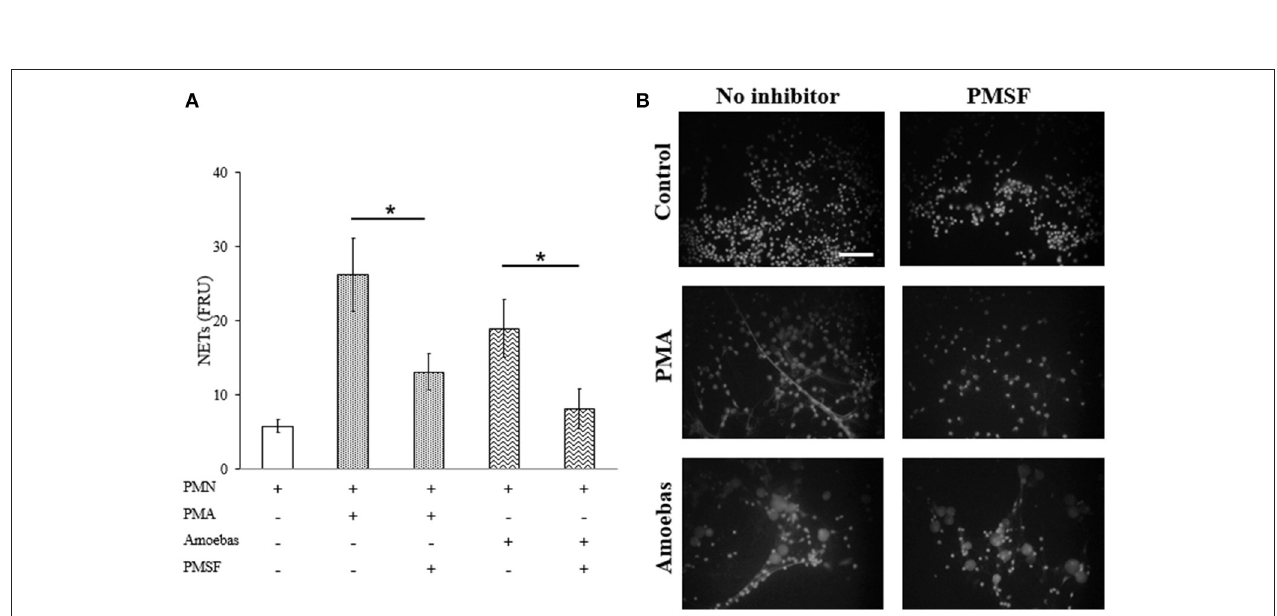
FIGURE 10 | Serine protease activity is required for NETosis induce by E. histolytica trophozoites. (A) Neutrophils (3 × 10 5 ) were pre-incubated with 1mM PMSF or DMSO for 30min and then stimulated with 20nM PMA or co-cultured with trophozoites (1.5 × 10 4 ) during 4h. Supernatants were collected, mixed 1:1 with SYTOX Green (500nM) and fluorescence was measured. NETs amount is expressed in fluorescence relative units (FRU). Values are means ± SD of three independent experiments in triplicate. * p < 0.001. (B) Neutrophils were treated as describe previously, fixed and stained with DAPI. Images were taken at 60x magnification. Scale bar 50 µ